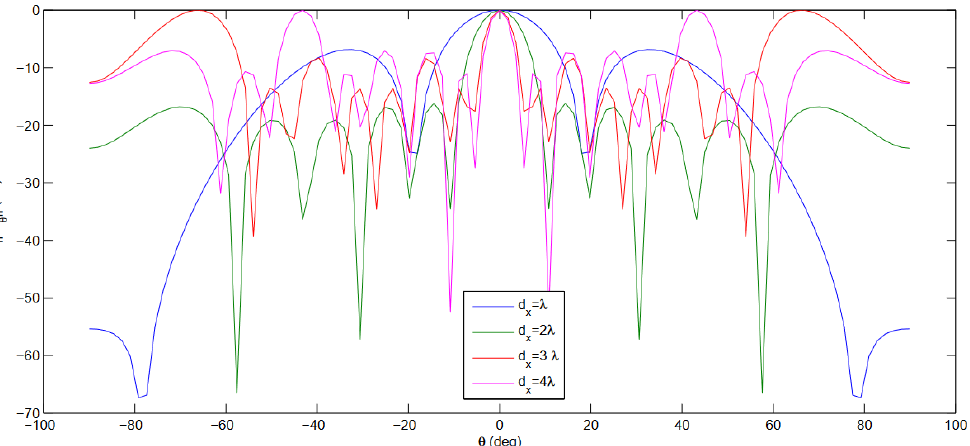
Figure 18. Radiation pattern computed with a MoM-GEC method against the motifs number at the operating frequency (f) of 5.4 GHz (periodic array).